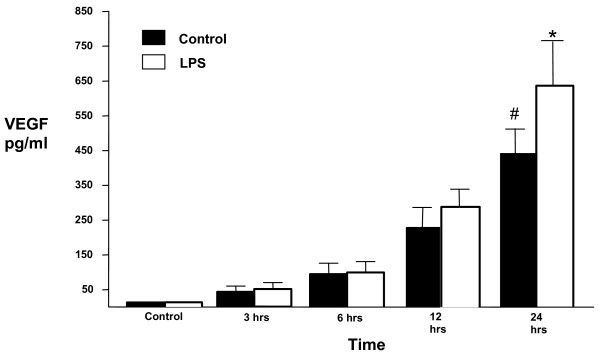
ATII cell supernatant levels of VEGF protein significantly increases with time in unstimulated cells, unstimulated cell supernatants control v 24 hrs, filled bars, (#p < 0.01) with a significant increase in response to LPS 100 ng/ml at 24 hours, unfilled bars, (*p < 0.05), ANOVA with post hoc Bonferroni.